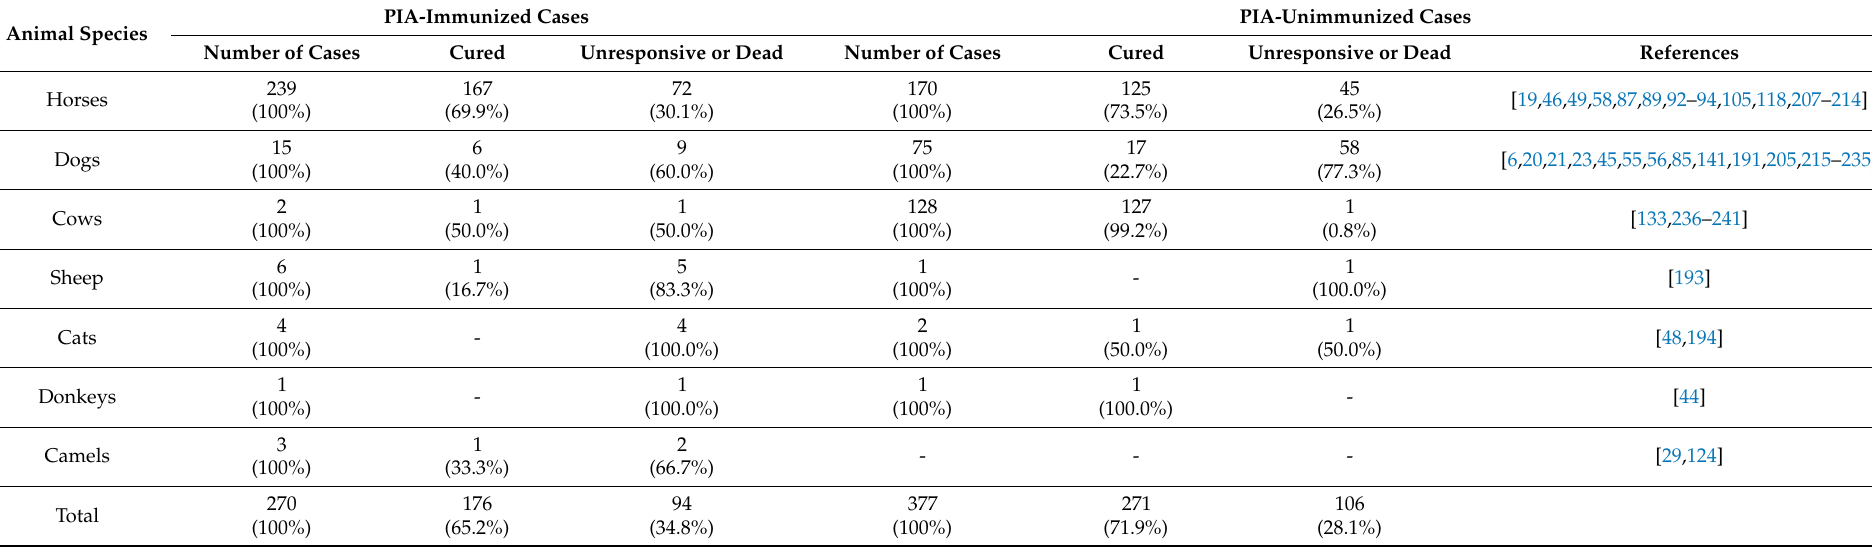
Table 5. Treatment outcomes of pythiosis in animals with (270 cases) or without (377 cases) the P. insidiosum antigen (PIA)